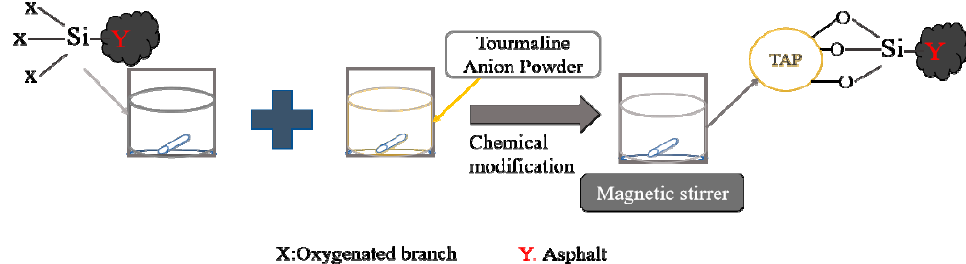
Figure 1. Surface modification process of TAP.